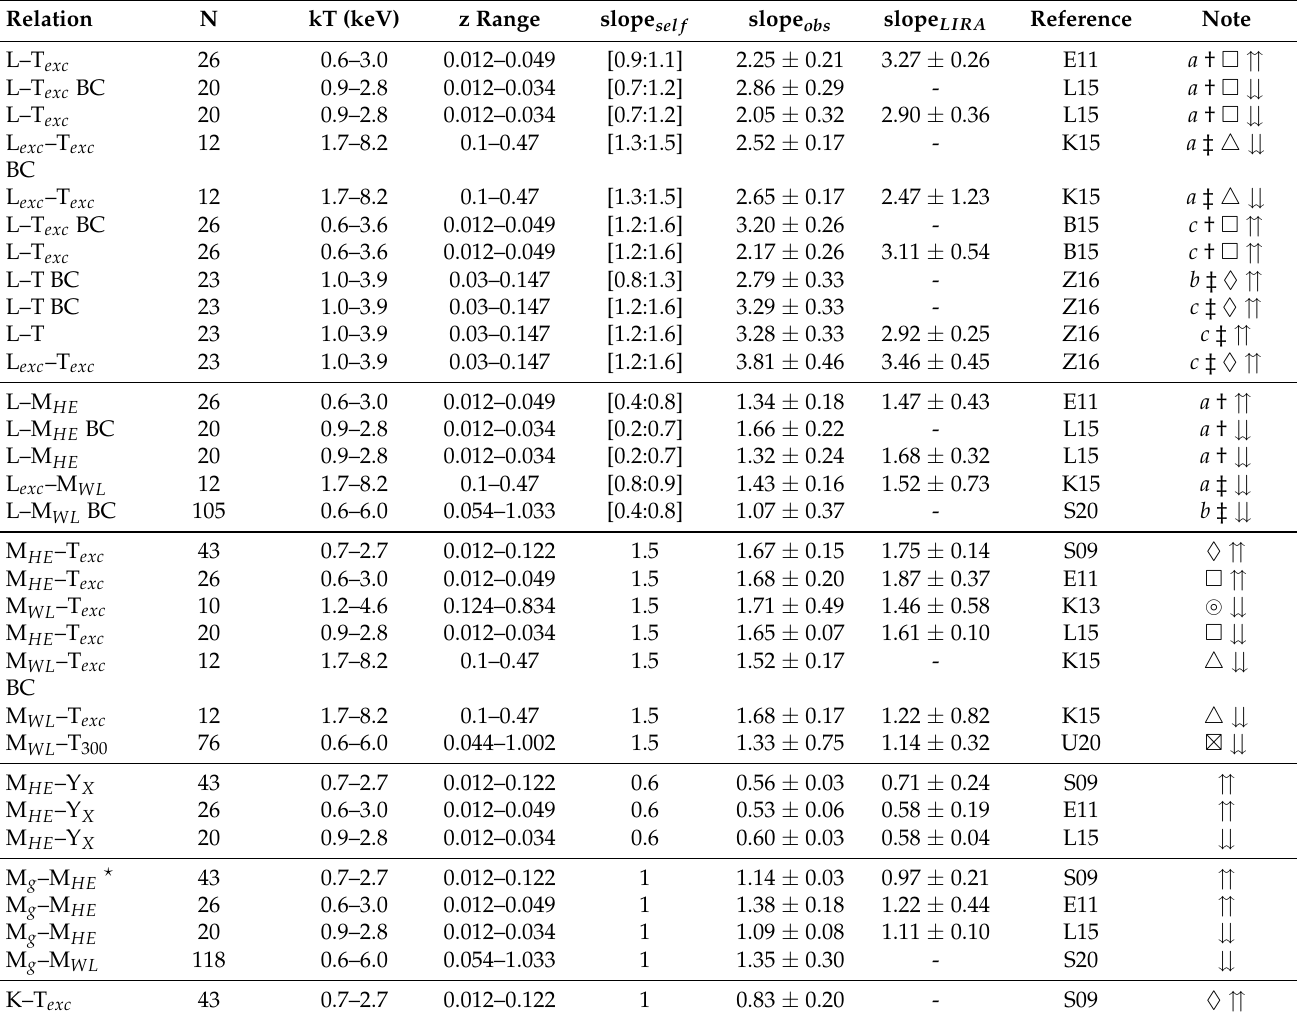
Table 2. Overview of the most recent published scaling relations for galaxy groups based on XMM–Newton and Chandra data. Relation N kT (keV) z Range slope self slope obs slope LIRA Reference